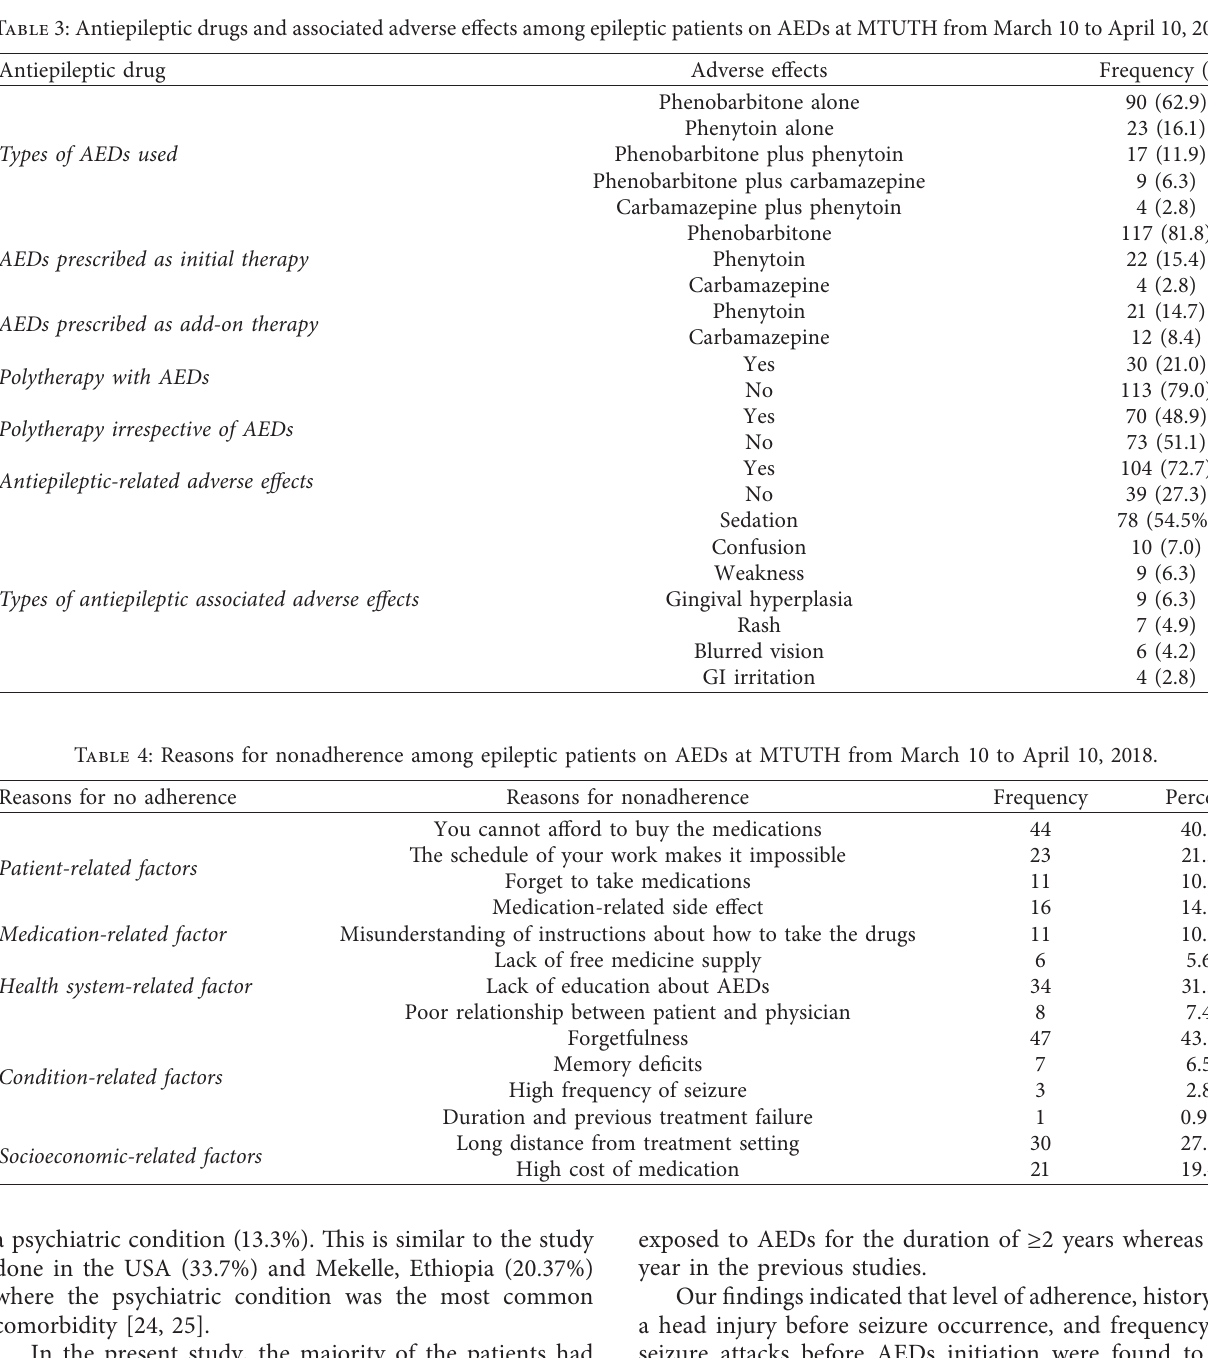
Table 3: Antiepileptic drugs and associated adverse effects among epileptic patients on AEDs at MTUTH from March 10 to April 10, 2018. Antiepileptic drug